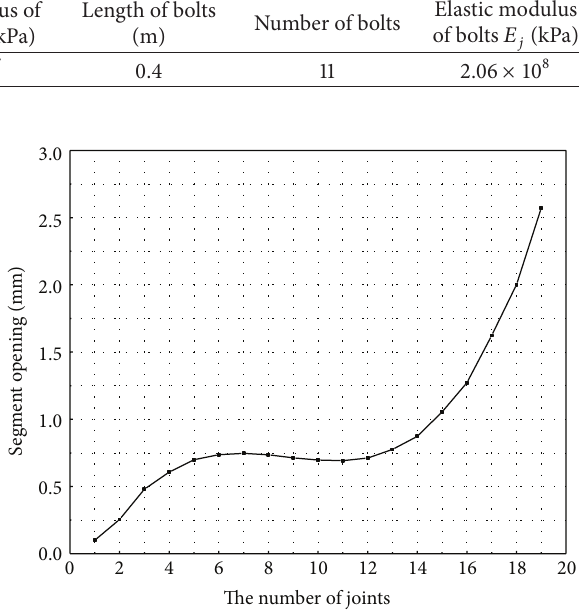
Figure 4: Schematic representation of the model employed for the supporting structure and segments.